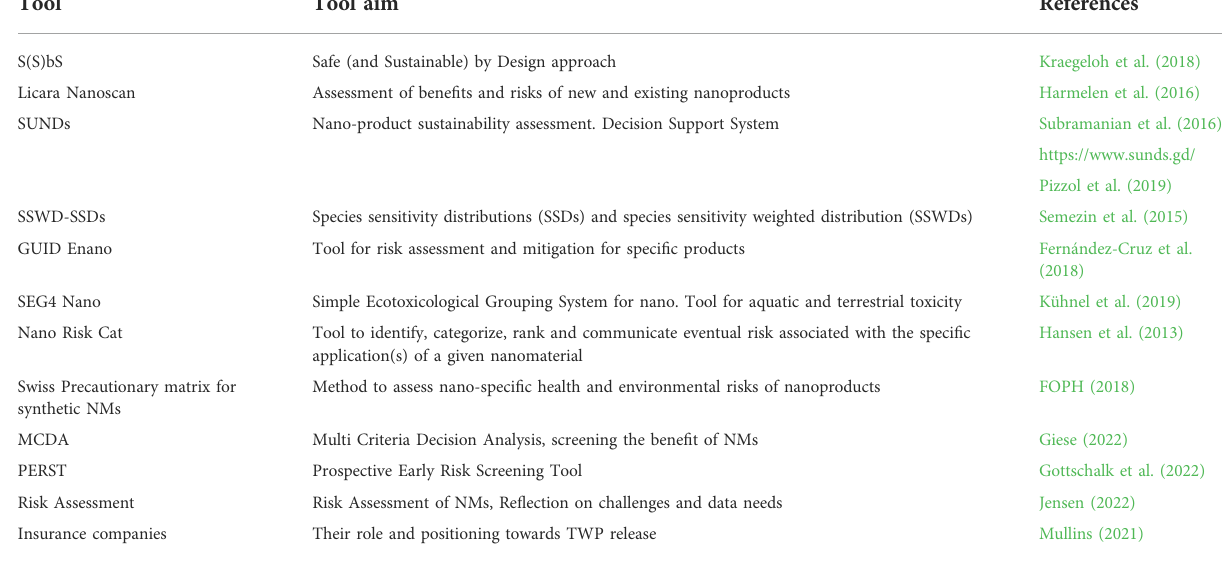
TABLE 1 List of tools and approaches for risk assessment integrated into the web based governance portal, and tested by NMBP13 experts, for potential useful contribution to nano risk governance of TWP.